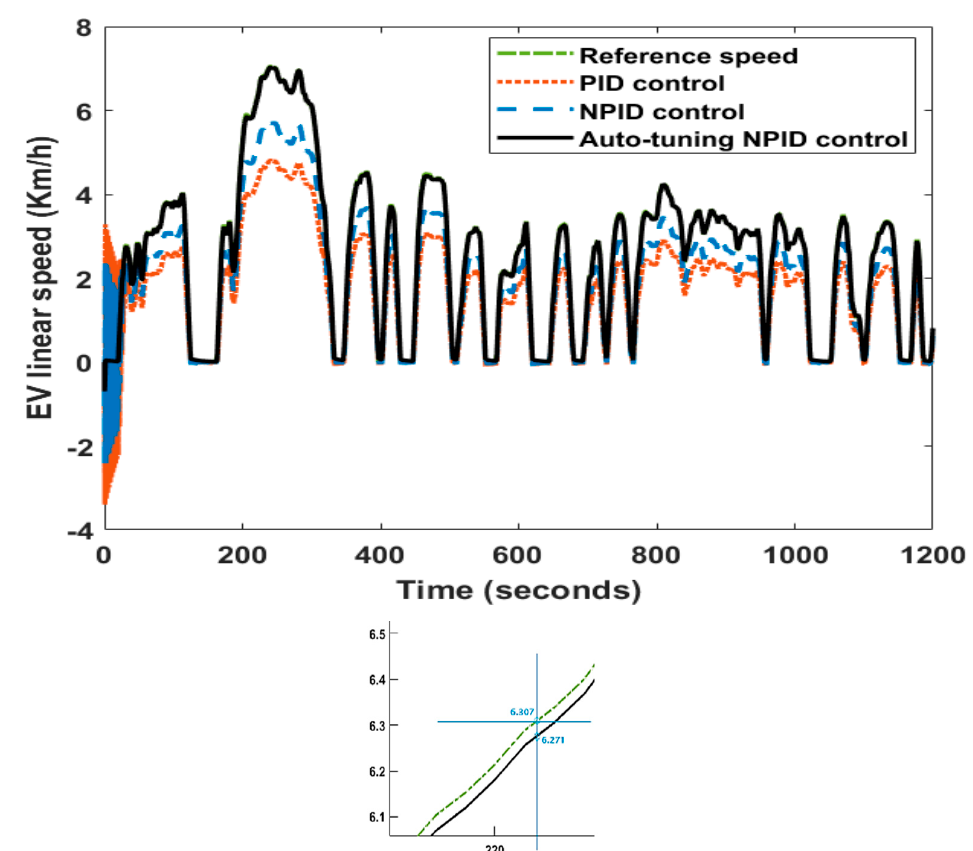
Figure 9. Performance of the PID, NPID, and auto-tuning NPID to track the UDDS test.